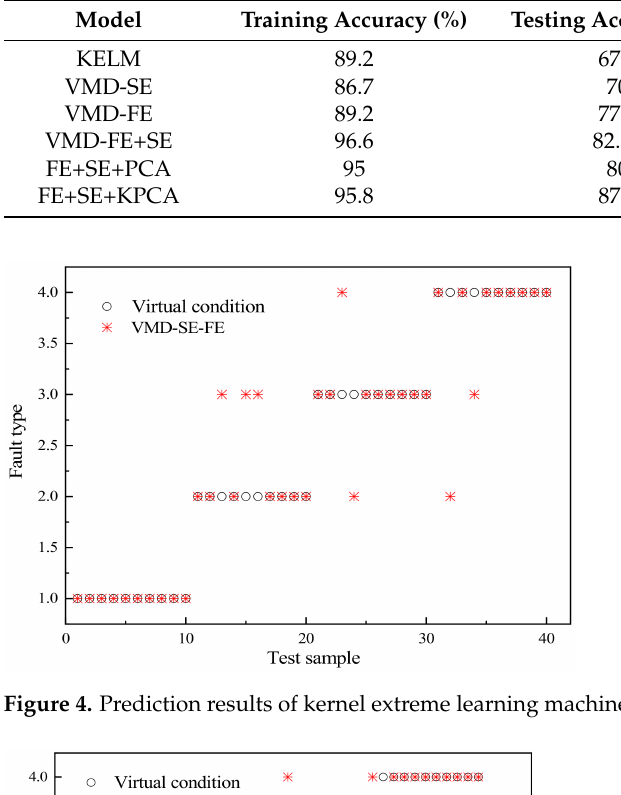
Table 6. Performance comparison of fault diagnosis models based on nuclear extreme learning machine.